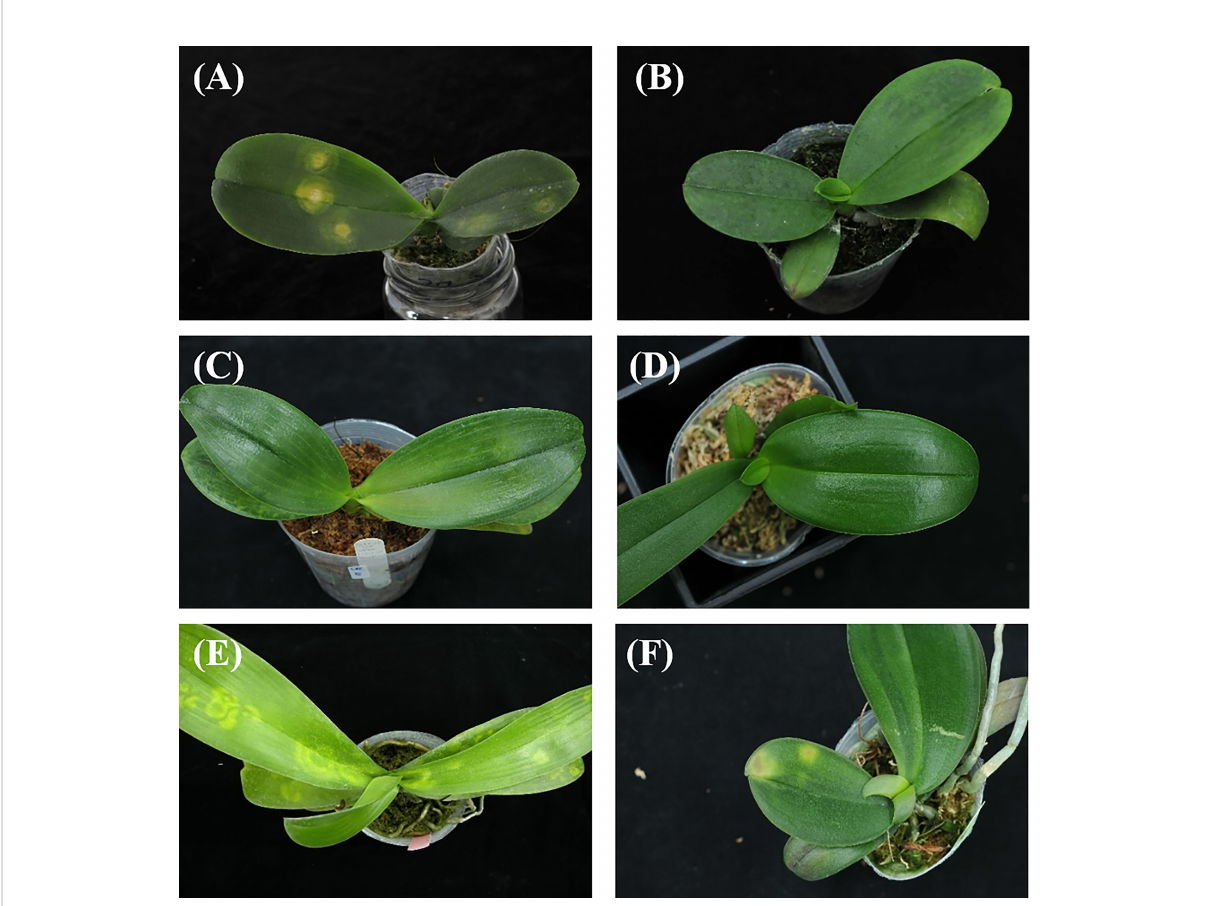
FIGURE 1 Image examples of orchids: (A) Capsicum chlorosis virus (CaCV) infection, (B) Cymbidium mosaic virus (CymMV) infection, (C) Odontoglossum ringspot virus (ORSV) infection, (D) health, (E) and (F) others.